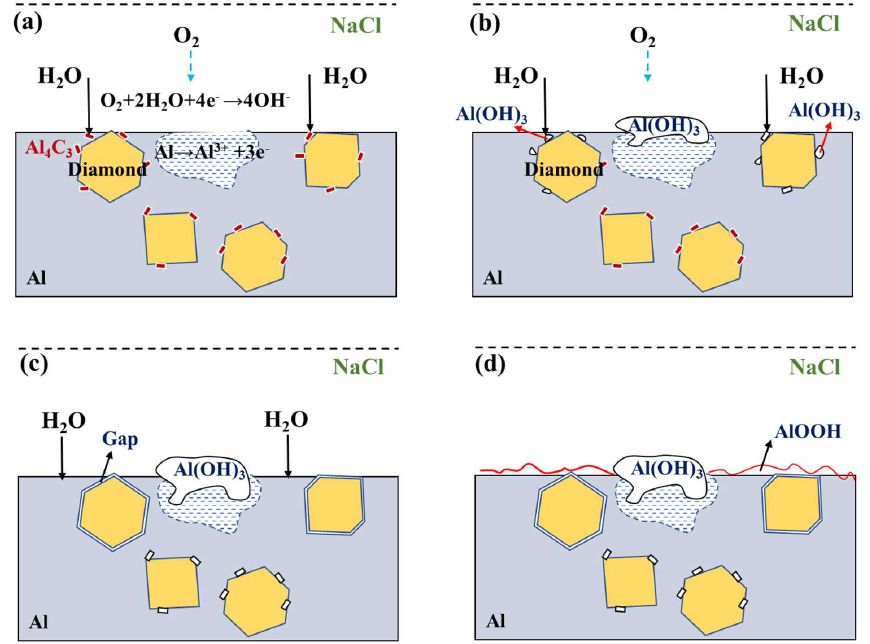
Figure 9. Schematic diagram of corrosion process of diamond/aluminum composite: ( a ) hydrolysis of Al 4 C 3 and corrosion of aluminum; ( b ) formation and accumulation of corrosion product Al(OH) 3 ; ( c ) corrosion creates gaps between diamond and aluminum; ( d ) the oxidation reaction of aluminum matrix forms AlOOH to inhibit further corrosion.